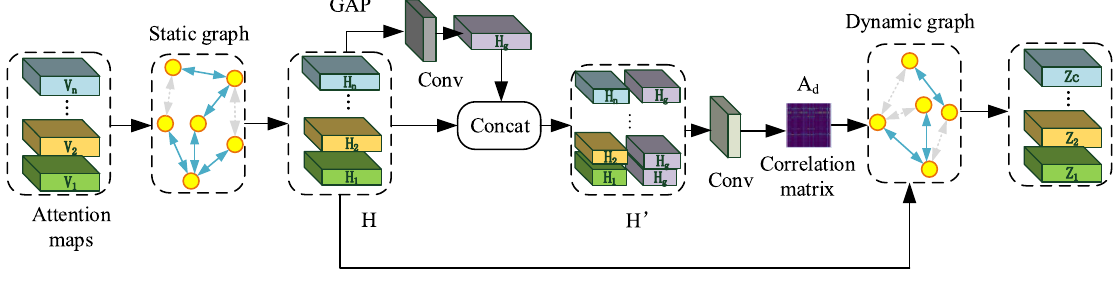
Figure 4. Dynamic graph convolution